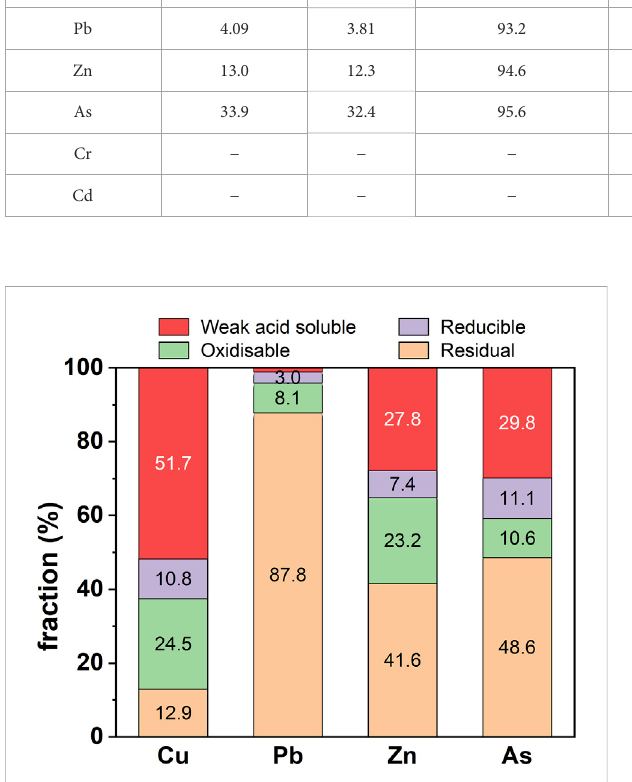
FIGURE 2 Heavy metals chemical fractions in the low-grade copper sul fi de tailings using the modi fi ed BCR sequential